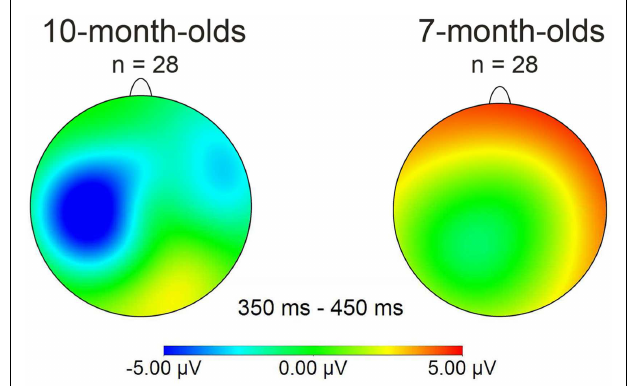
FIGURE 3 | Mean distribution plots for the ERP effect of familiarity (familiarized target – unfamiliar control words) in the 350–450ms time window for overall group performance of 10-month-olds (left) and 7-month-olds